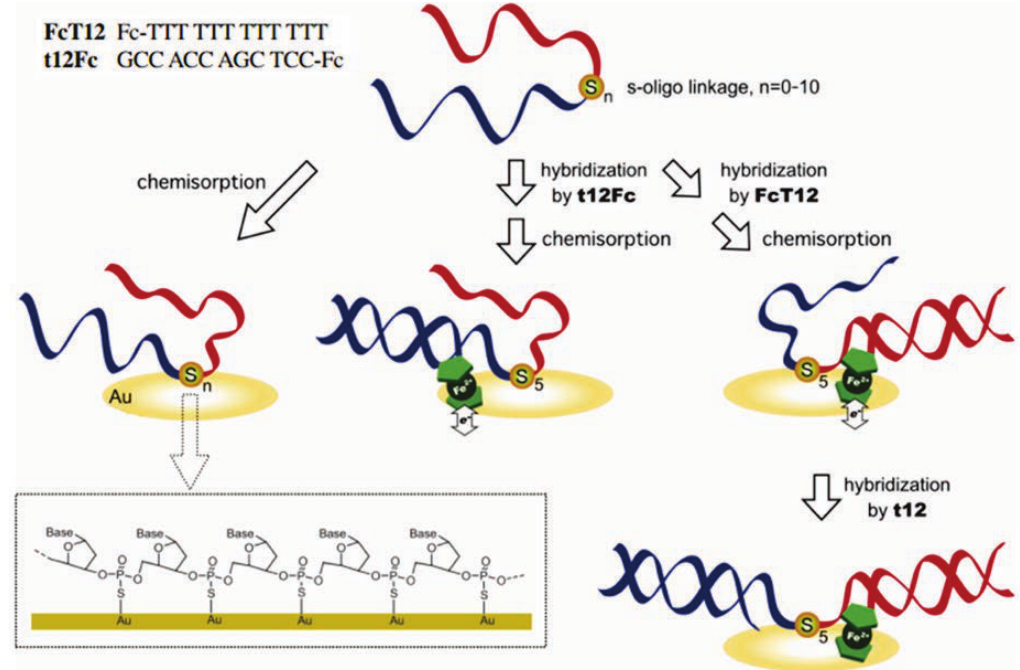
Figure 2. Schematic illustration of the covalent attachment of the model capture probe DNA molecule, oligodeoxynucleotide phosphorothioate (s-oligo), or its corresponding half-hybridized species formed with a ferrocene-modified complementary DNA. In the box is shown the expected surface structure of the s-oligo surface-adlayer. Reprinted with permission from [32]. Copyright 2012 Analytical Sciences